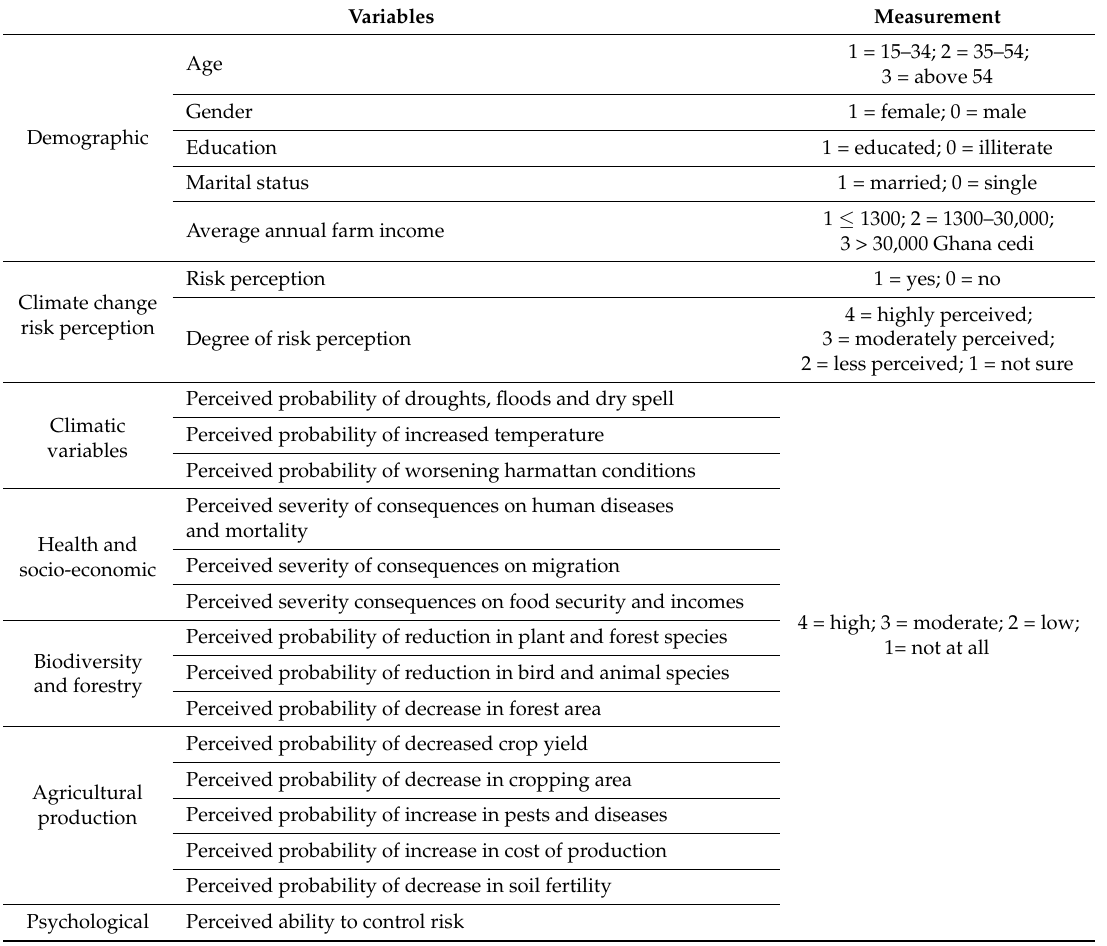
Table 1. Description of variables and measurements used in data